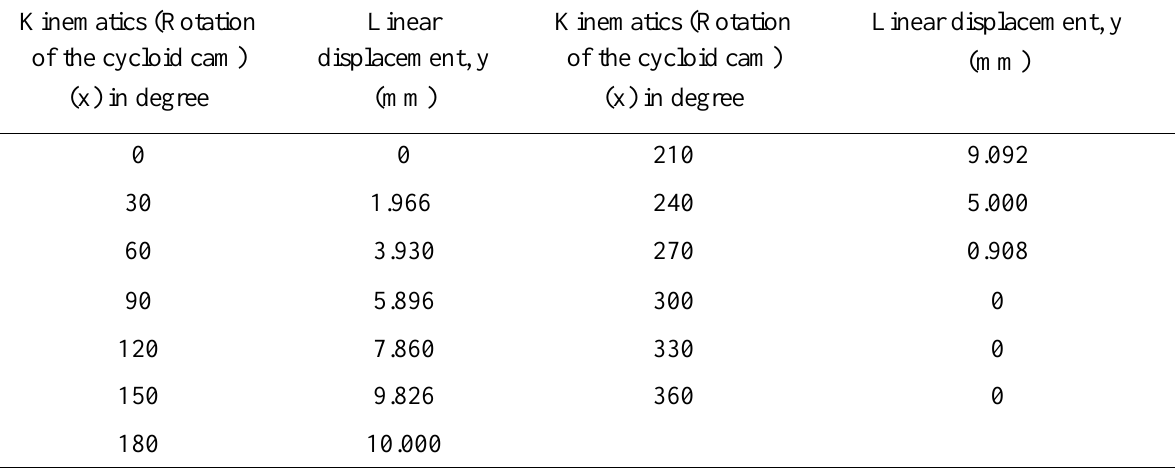
Table 6. The theoretical displacement of the cam from the circumference of the base circle to its profile (the kinematic motion of the follower during the rotation of the cycloid cam) for medium cam of maximum displacement (H), 10 mm from the base circle of the